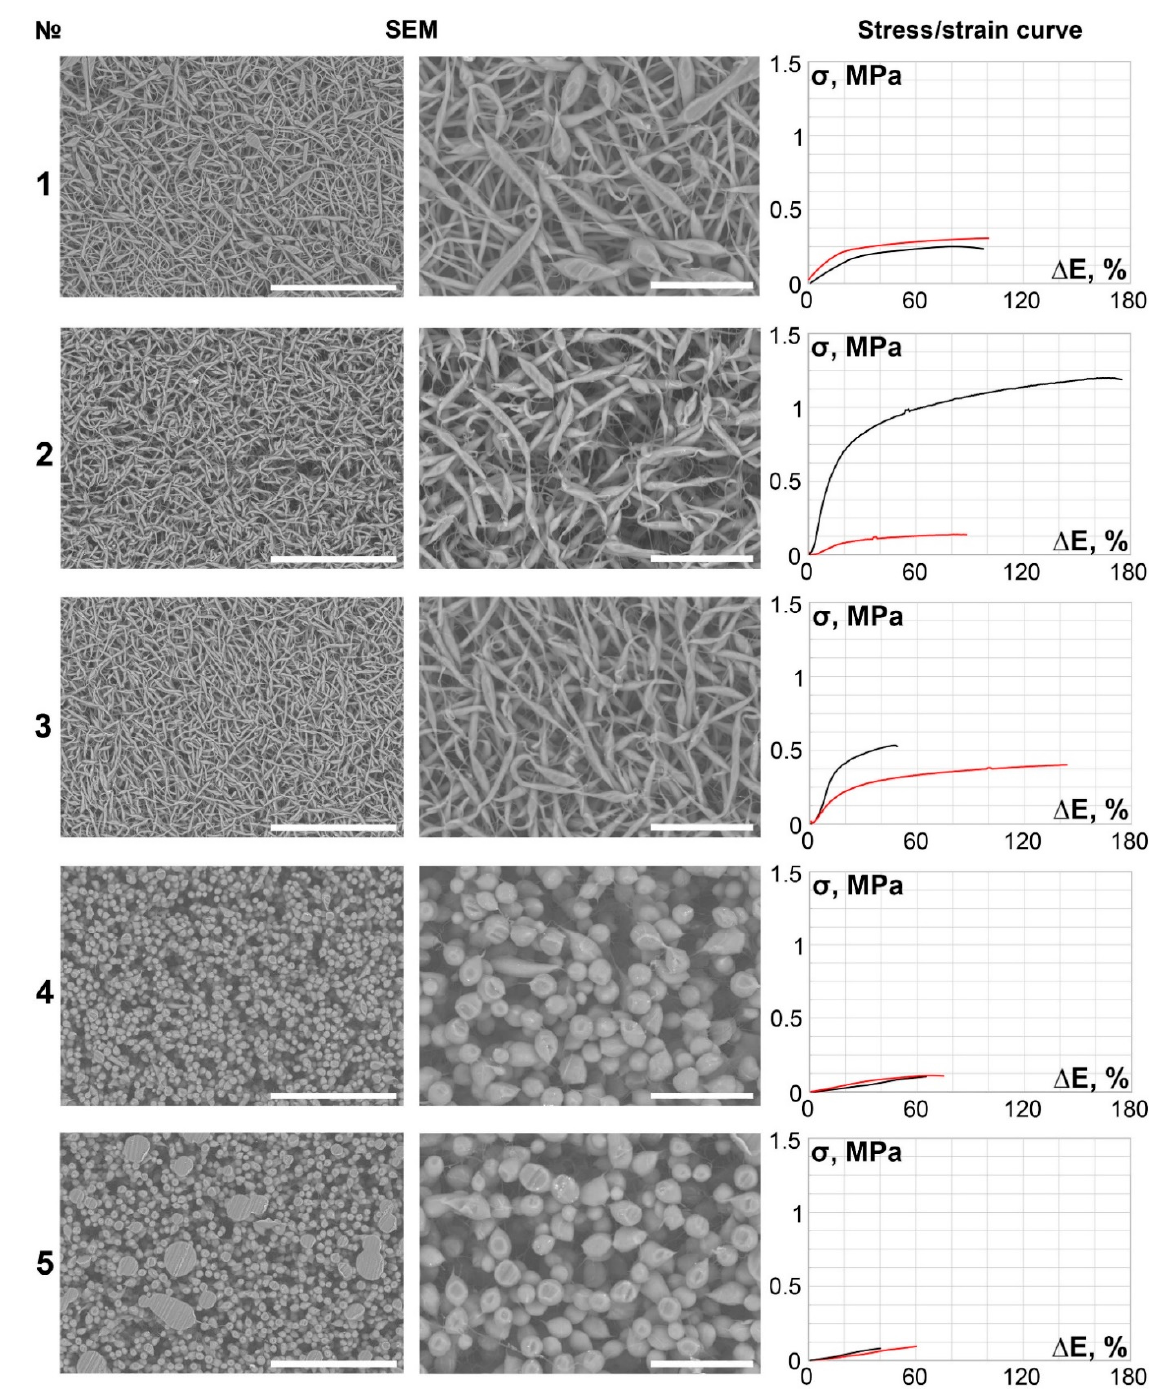
Figure 1. SEM images (×250 magnification, scale bar 200 µm and ×700 magnification, scale bar 50 µm) and stress/strain curves of tested 5% PCL samples. Red curves reflect stress/strain plotting in the axial direction; black curves correspond to circumferential stretching.